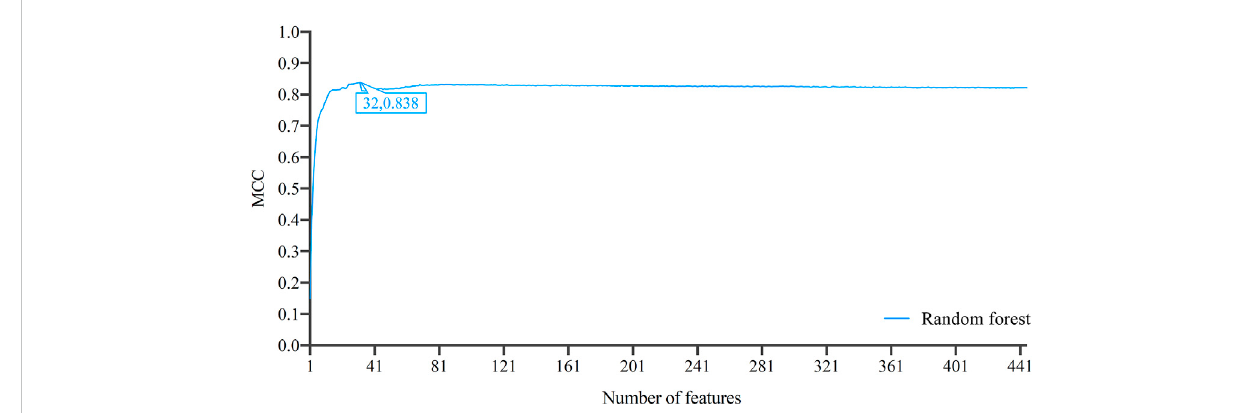
FIGURE 5 Incremental feature selection (IFS) curves of random forest based on the list by applying LightGBM to the features reconstructed by autoencoder. The optimal MCC of 0.838 is achieved when the number of features is 32, which is better than that based on the original 0 – 1 representation of